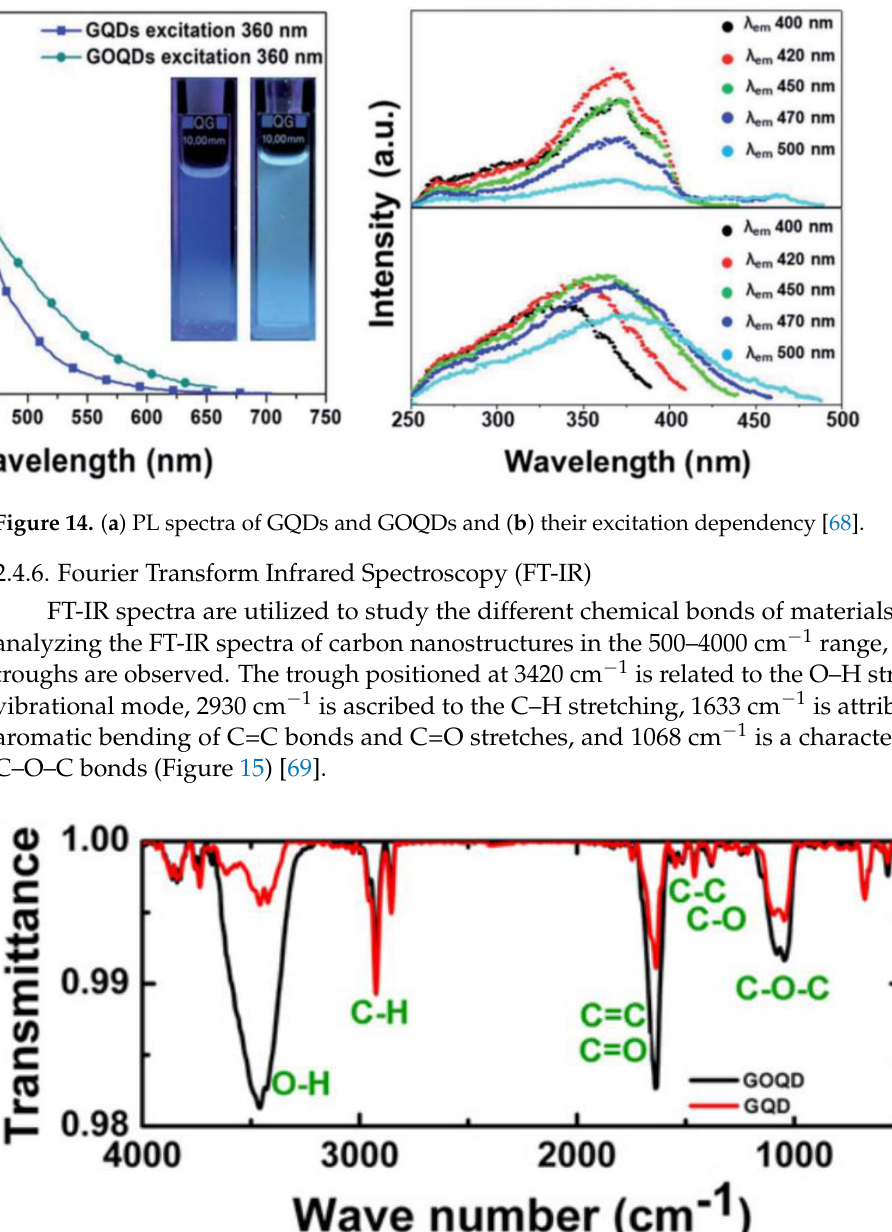
Figure 15. FT-IR spectrum of GQDs (red) and GOQDs (black). Reprinted with permission from Ref. [69]. 2014, IOP Publishing.